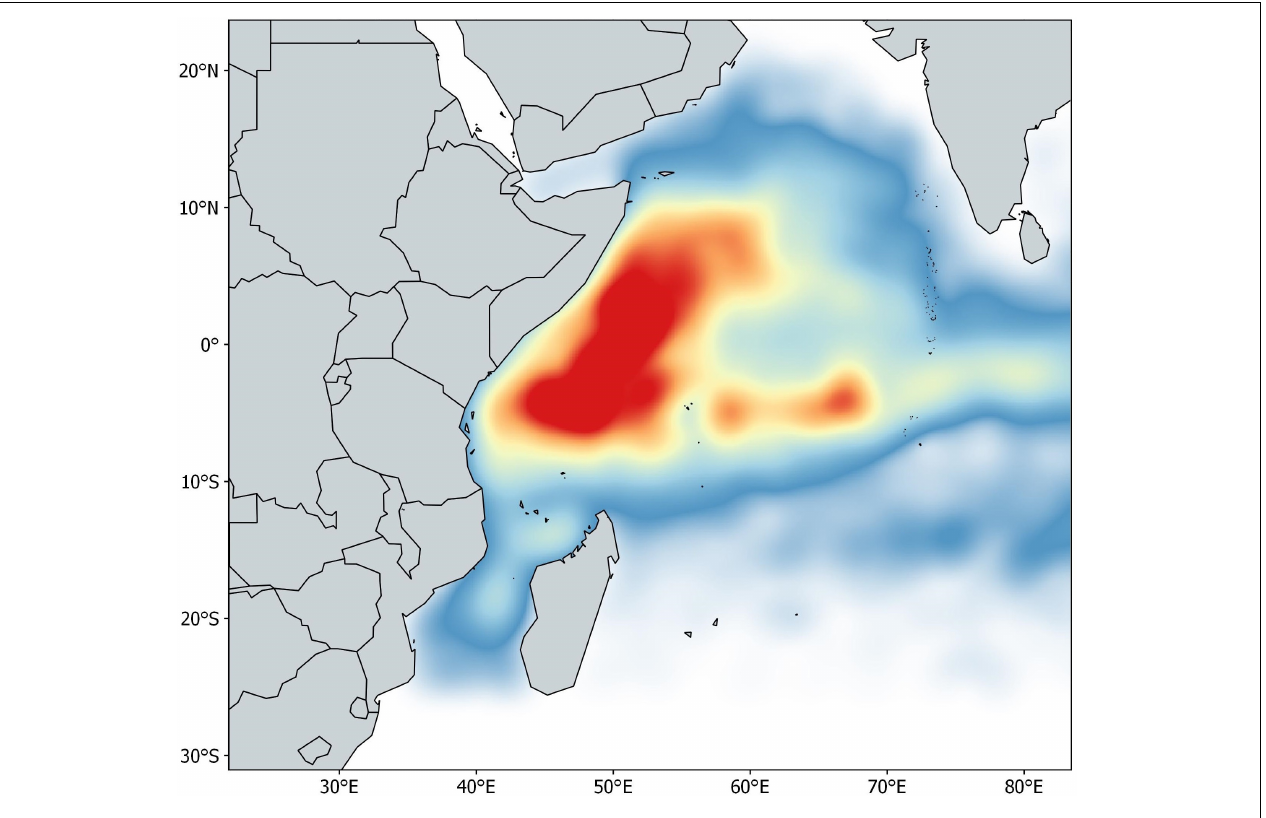
FIGURE 1 | Density map of acoustic samples in the Indian Ocean from January 2012 to May